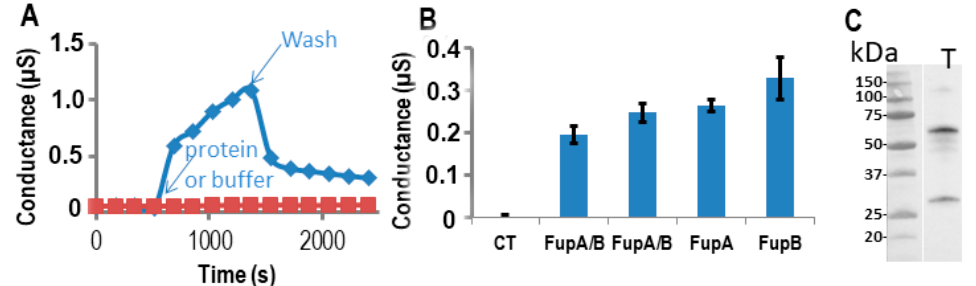
Figure 4. Measurements of Fup protein porin activity using impedance spectrometry. The proteins were digested by the TEV enzyme in the well. ( A ) The conductance of the t-LBM after the insertion of FupA/B (blue diamonds) and without protein (red squares). Time of protein (or buffer) addition and washes are indicated. ( B ) Conductance of the t-LBM ( ± SD) after the insertion of FupA or FupB compared to FupA/B (in two independent wells), and no protein (CT). The conductances are the mean of the conductances measured over 10 min. ( C ) Immunoblot analysis of FupA solubilized in the t-LBM well by SDS and revealed by antibodies specific to FupA (laneT). Marker molecular weights are indicated (kDa).